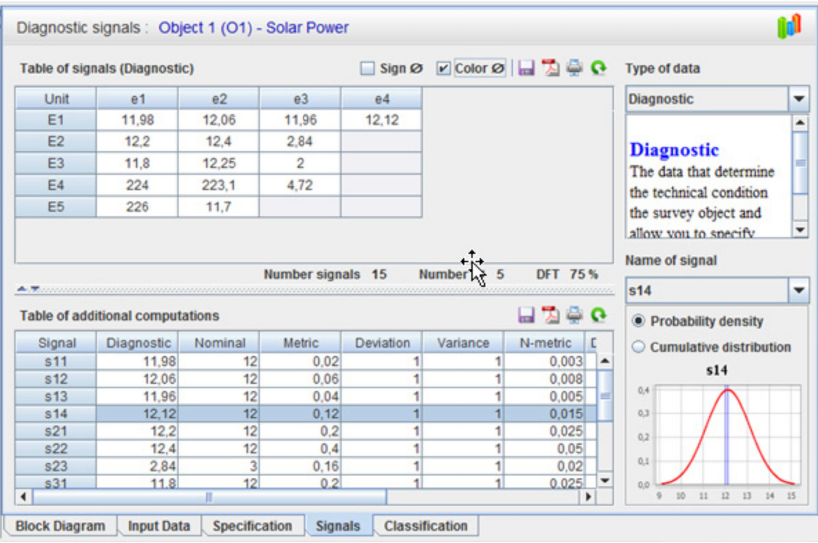
Figure 9. Program screen DIAG 2 in the form of “Diagnostic signals table”.